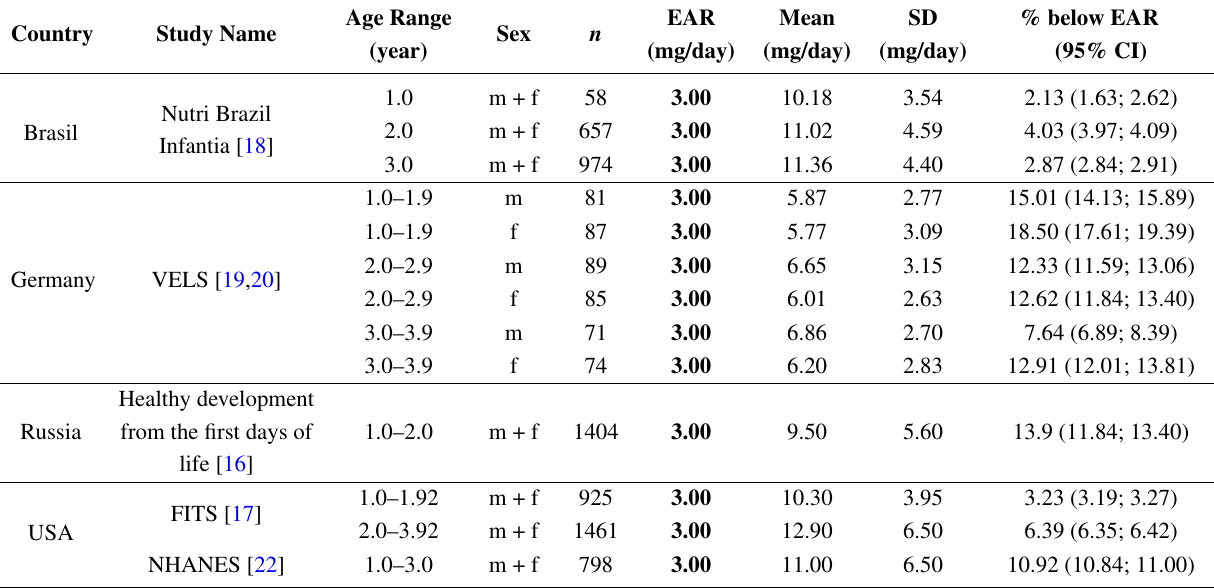
Table 8. Mean iron intake (mg/day) and prevalence of inadequate intake (% below EAR) in Brazil Germany, Russia and the United States.